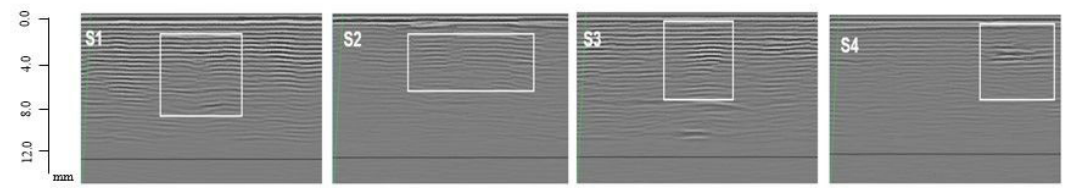
Figure 8. B-Scan images of the samples with fiber waviness – Group S. Scale shows the depths along direction z.